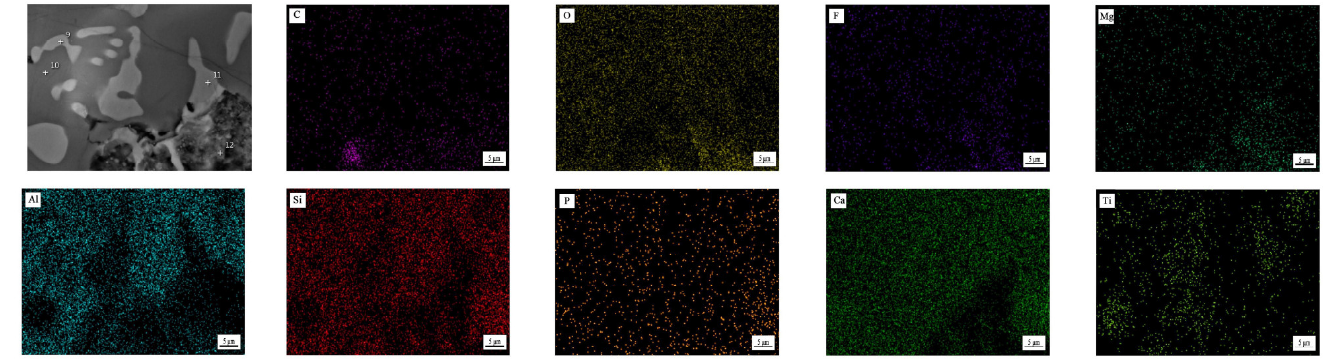
Figure 4. Sr‑8 SEM morphology, surface sweep, and point energy spectra.